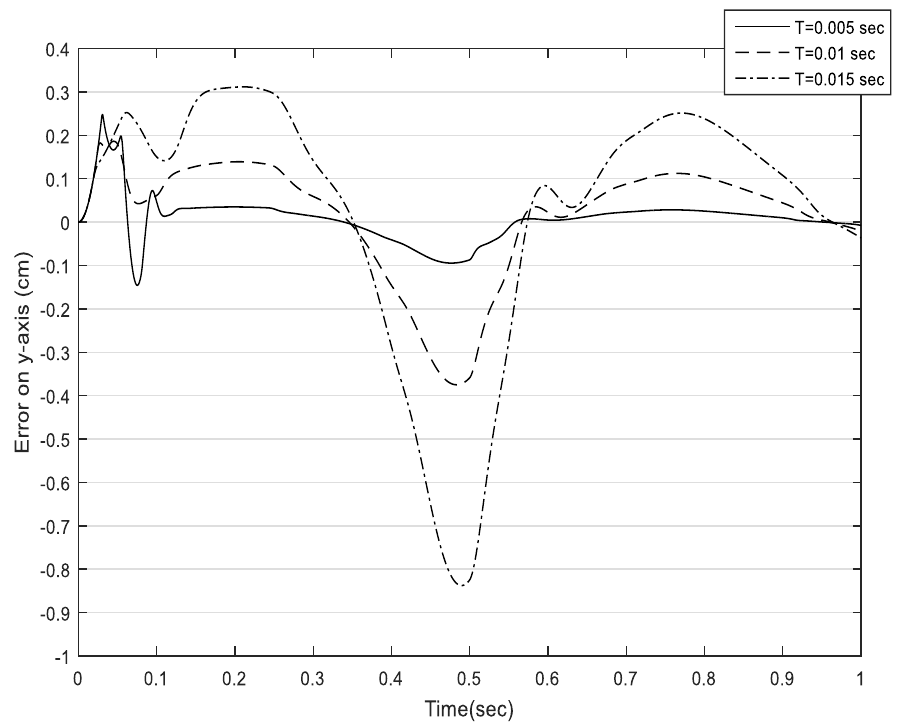
Figure 6. NGPC tracking errors on Y-axis for different prediction horizons.